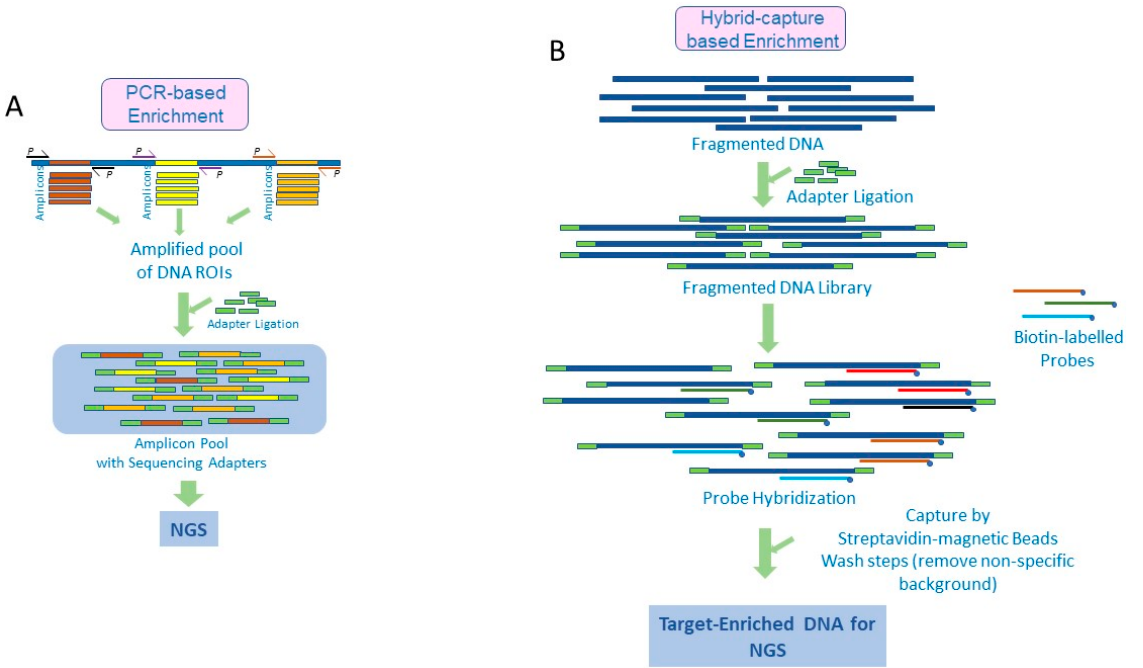
Figure 1. Target Enrichment Approaches for NGS. The underlying principles of the two prominent target enrichment technologies are depicted schematically. ( A ) The PCR amplicon-based method employs PCR amplification using sequence-specific, target-spanning primers to amplify and enrich the genomic regions of interest (targets). Postamplification, in a ligation step, sequencing adapters and barcode indexes are included to generate the genomic library for sequencing. ( B ) In the hy- brid capture method, the input genomic DNA is fragmented using enzymatic or acoustic methods followed by ligation of adapters and barcode indices to generate a genomic library. This is sub- jected to hybridization using biotin-labeled target sequence-specific probes followed by capture of the hybridized probes using Streptavidin magnetic beads to isolate genomic regions of interest for